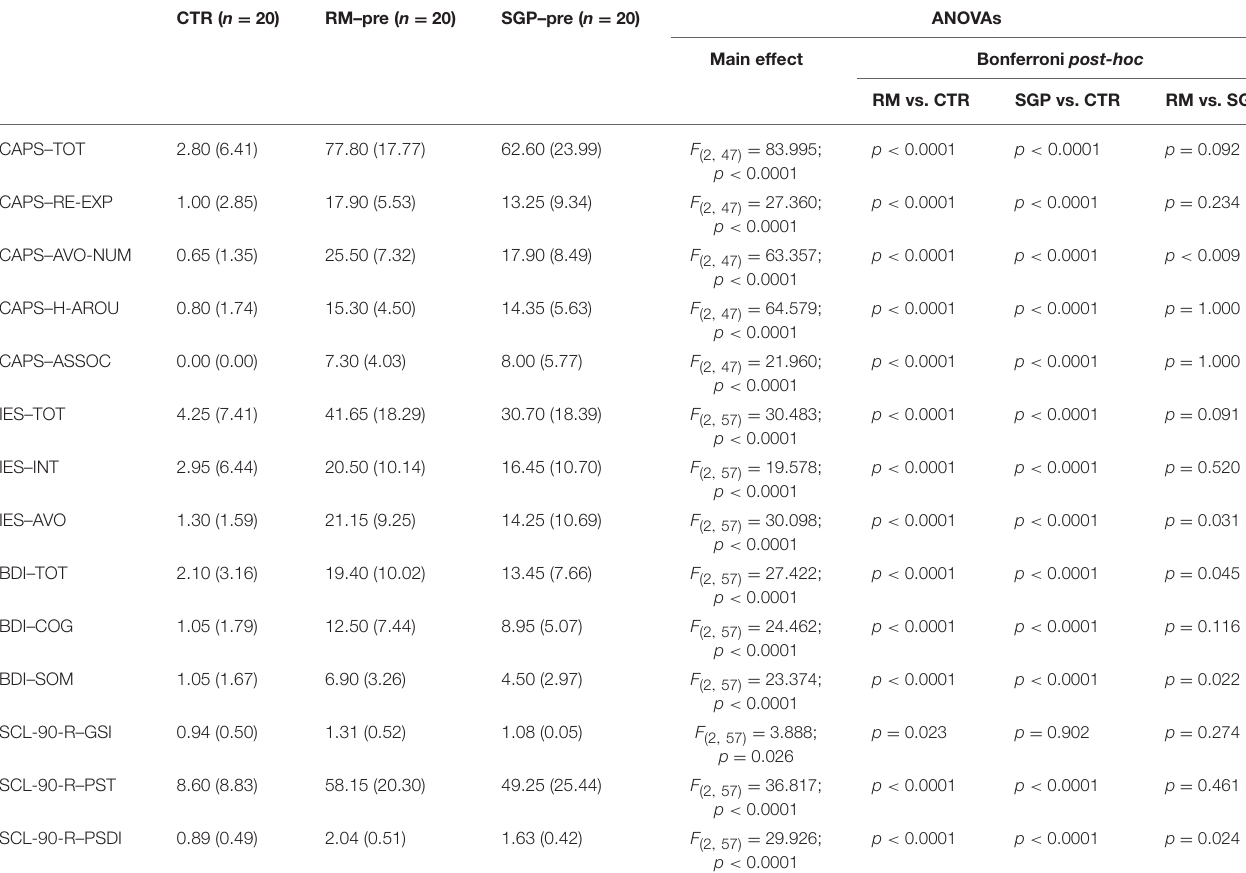
TABLE 2 | Descriptive and univariate (pre-EMDR) statistics of psychopathological scales are showed. CTR ( n = 20 ) RM–pre ( n = 20 ) SGP–pre ( n = 20 ) ANOVAs